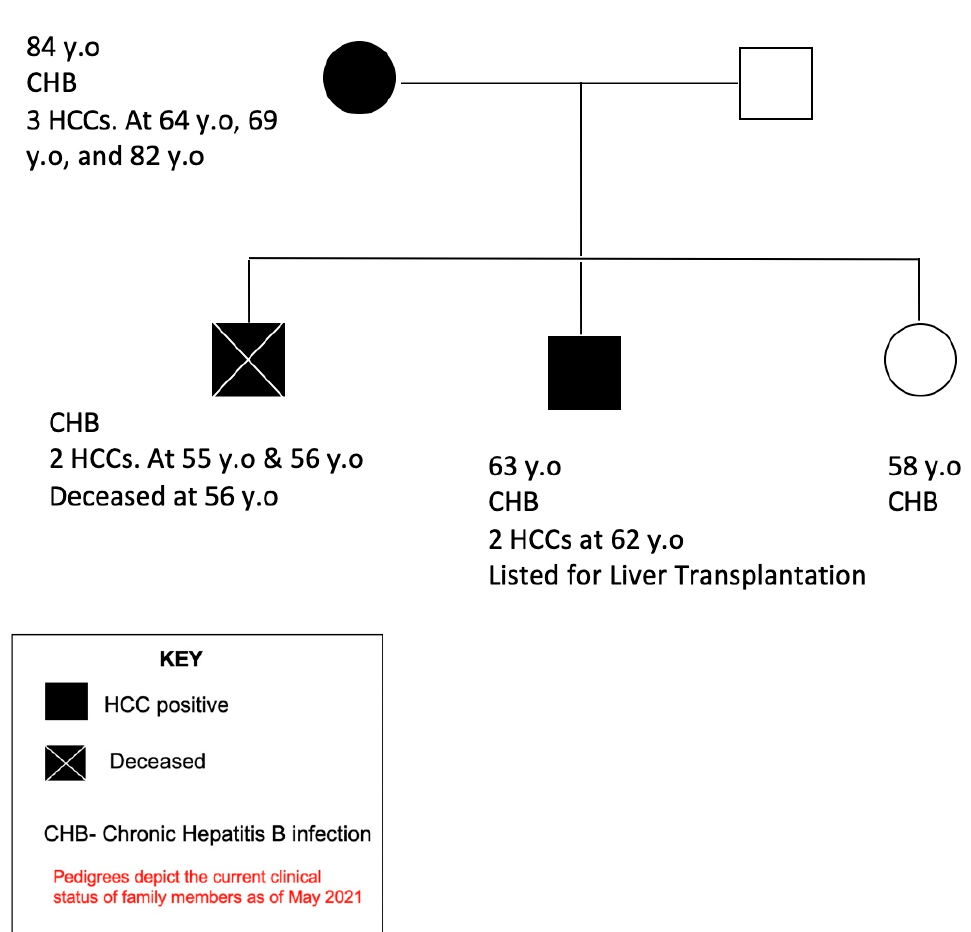
Figure 1. Pedigree of one family cluster (family 1) depicting the current clinical status of family members as of May 2021. Abbreviations: chronic hepatitis B (CHB), hepatocellular carcinoma (HCC), years old (y.o.).